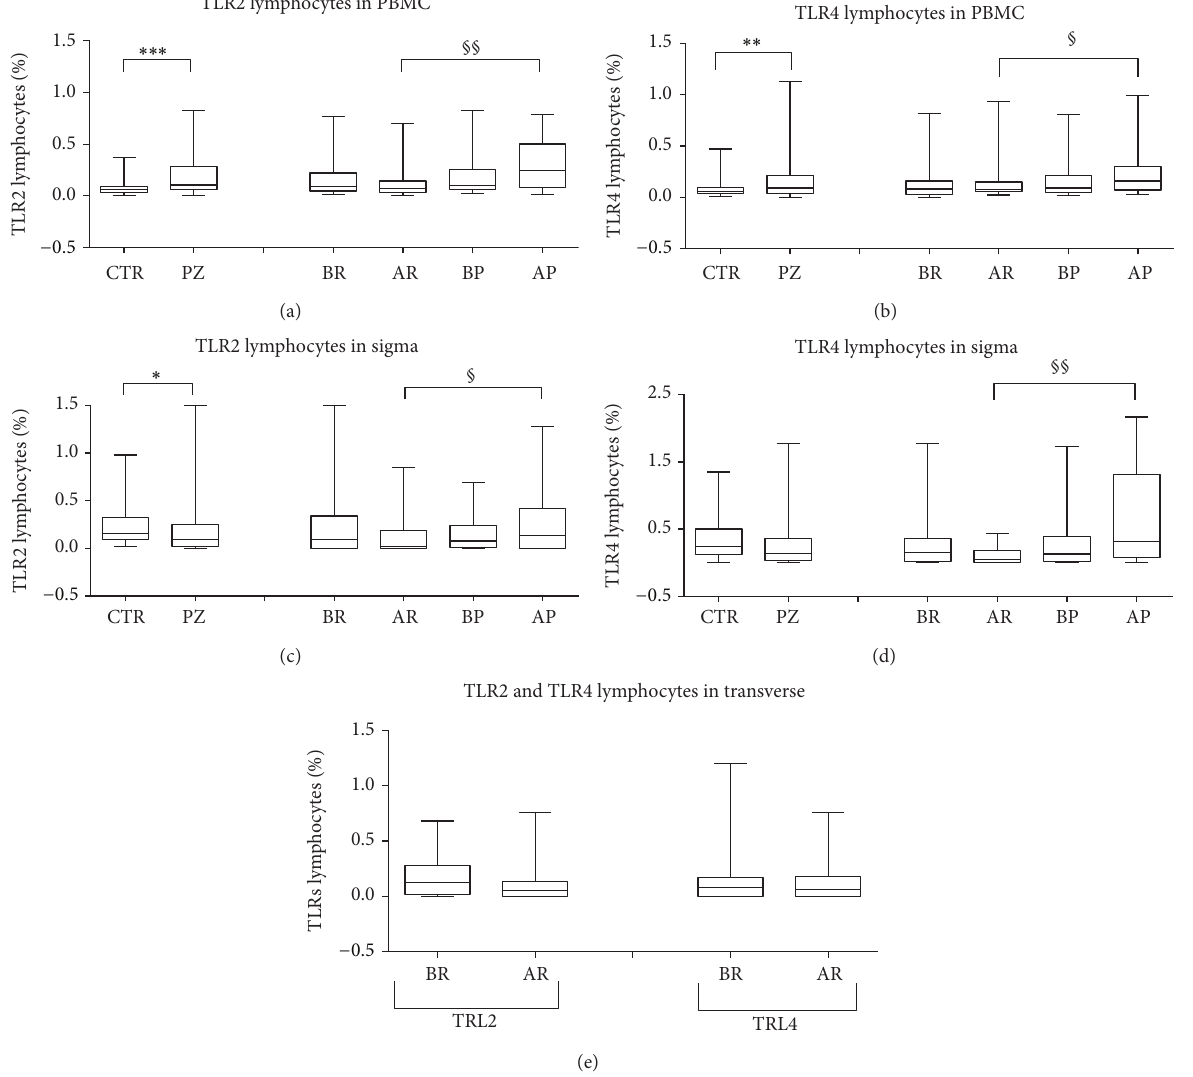
Figure 1: Expression of TLRs in lymphocytes. (a, b) TLR2 and TLR4 in peripheral blood lymphocytes, at baseline and after Rifaximin and placebo treatments. (c, d) TLR2 and TLR4 in sigma mucosa lymphocytes at baseline and after Rifaximin and placebo treatments. (e) TLR2 and TLR4 in transverse mucosa lymphocytes at baseline and after Rifaximin treatment. The values reported in box-and-whiskers plots show the minimum, the 25th percentile, the median, the 75th percentile, and the maximum. In particular, the whiskers go down to the smallest value (minimum) and up to the largest one (maximum), the top and bottom of the box are the 25th and 75th percentiles, and the line in the middle of the box is the median corresponding to 50th percentile ( ∗∗∗ 𝑃 < 0.001 , ∗∗ 𝑃 < 0.01 , ∗ 𝑃 < 0.05 patients versus control (health or baseline)); §§ 𝑃 < 0.01 , § 𝑃 < 0.05 between treatments. Healthy control (CTR), UDD patients (PZ), before Rifaximin (BR), after Rifaximin (AR), before placebo (BP), and after placebo